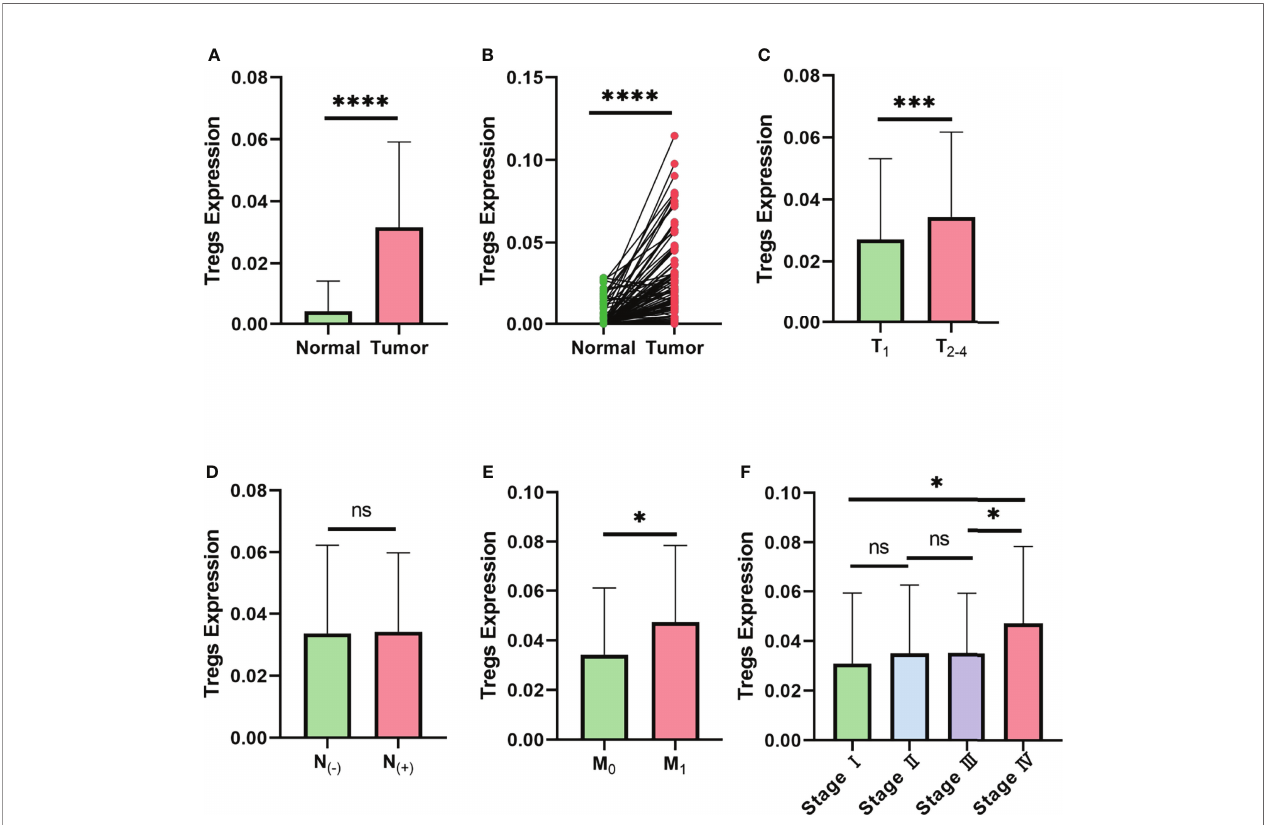
FIGURE 1 | Expression level of Tregs is associated with the clinical characteristics of breast cancer in TCGA database. (A) Expression level of Tregs between normal and cancer tissues of breast cancer patients in TCGA database. (B) Expression level of Tregs between paired normal and cancer tissues of breast cancer patients in TCGA database. (C) Expression level of Tregs in different T stages of breast cancer patients. (D) Expression level of Tregs among nodal status-negative and nodal status-positive breast cancer patients. (E) Expression level of Tregs in breast cancer with or without distant metastasis. (F) Expression level of Tregs between different AJCC anatomic stages. ns, not signi fi cant; * p < 0.05, *** p < 0.001, **** p <